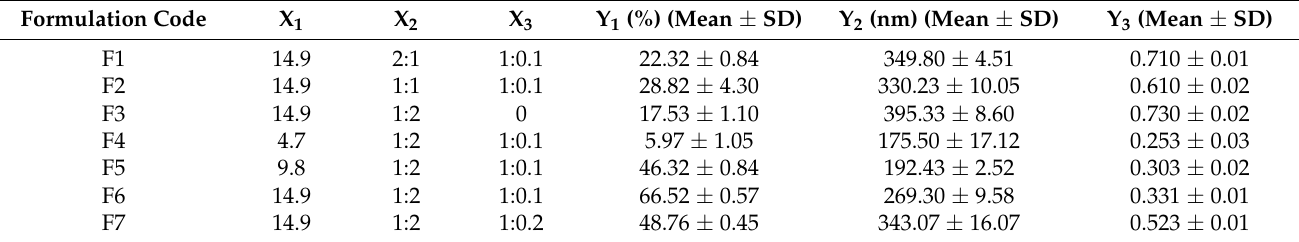
Table 1. In vitro characterization of ALN gel